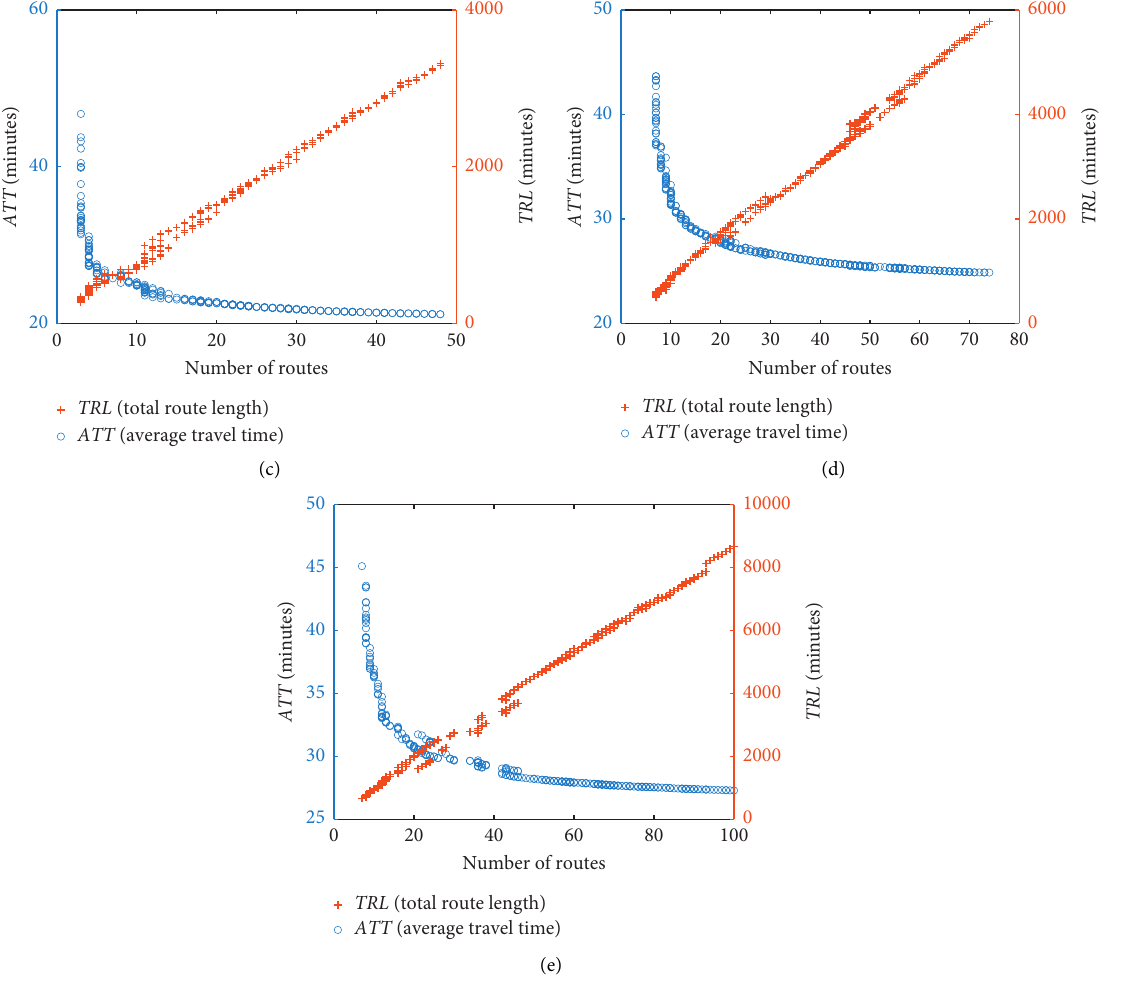
Figure 12: Effect of | R | on both objective functions in five networks. (a) Mandl’s network. (b) Mumford0. (c) Mumford1. (d) Mumford2. (e)